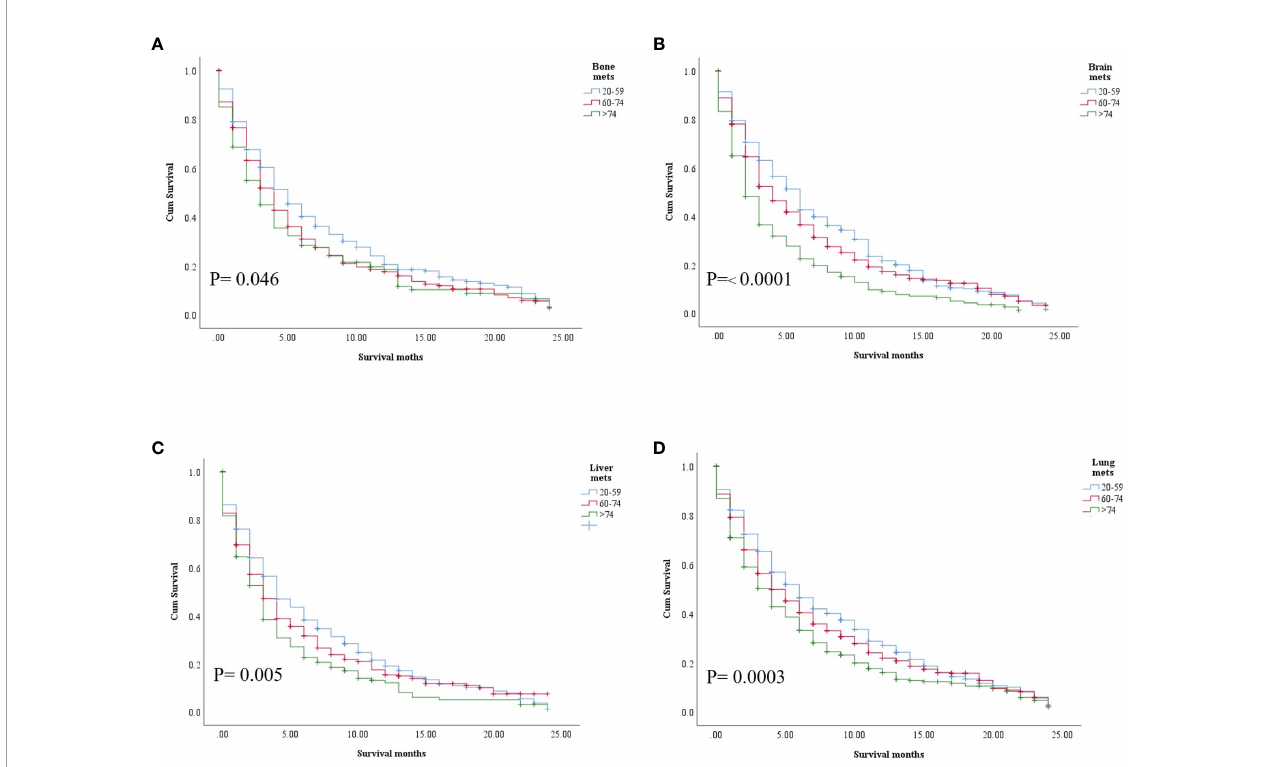
FIGURE 5 | Comparative sites of metastasis among the age groups. (A) Bone. (B) Brain. (C) Liver. (D)